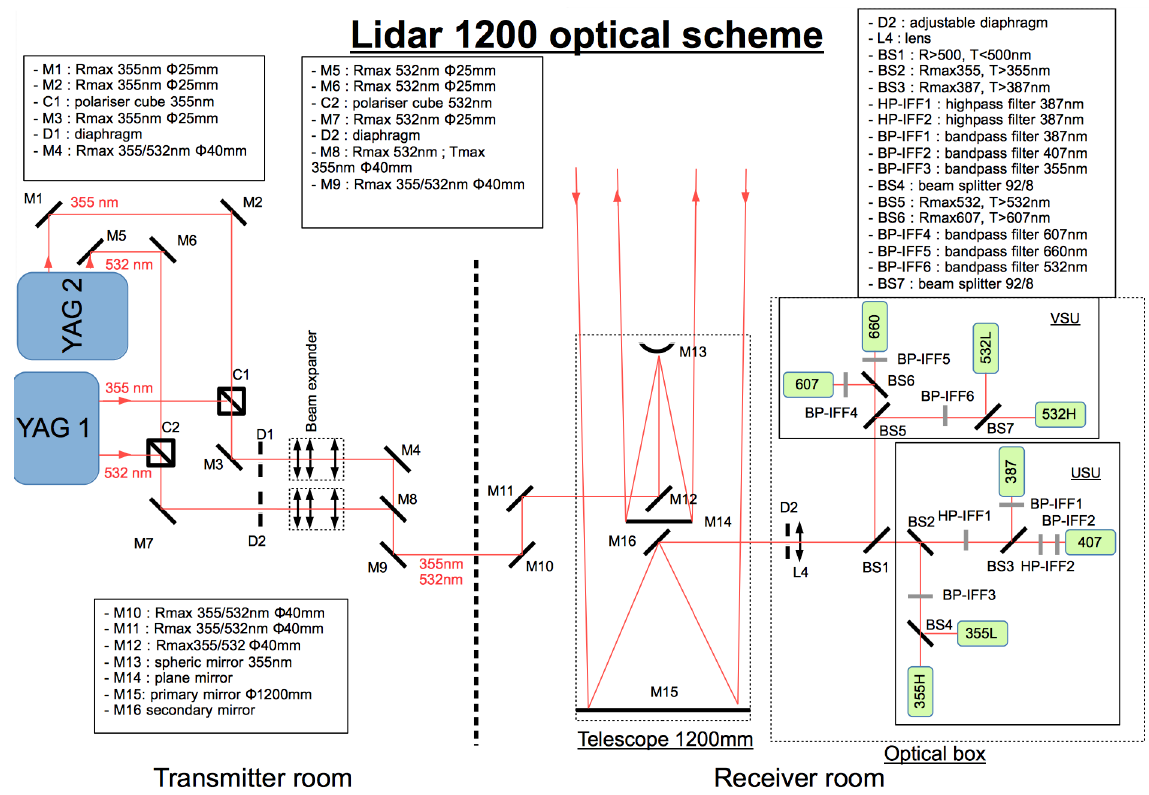
Figure 1. Optical scheme of the Mäido lidar. The optical components of the visible separation unit (VSU) and the UV separation unit (USU) are described in the